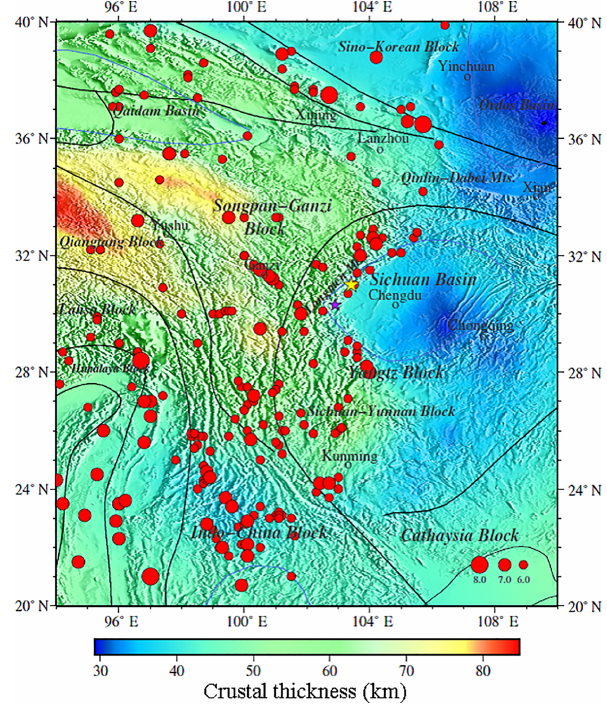
Figure 6. Crustal thickness of the western Yangtze craton from this